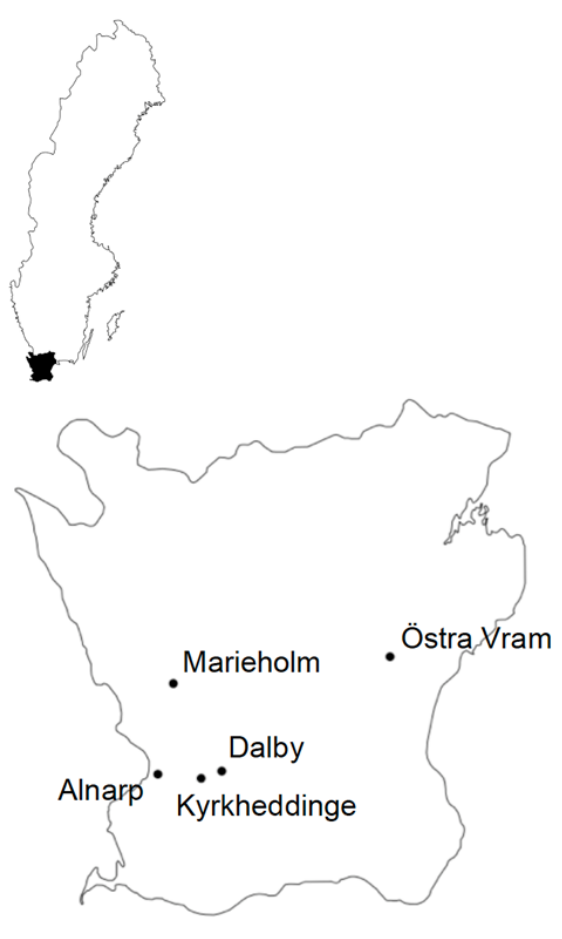
Figure 3. Map of the county Scania, South Sweden showing the four locations where the feral Brassica napus plants were collected (Marieholm, Östra Vram, Dalby, Kyrkheddinge). The field experiments took place at locality Alnarp. Map by C. Anderberg